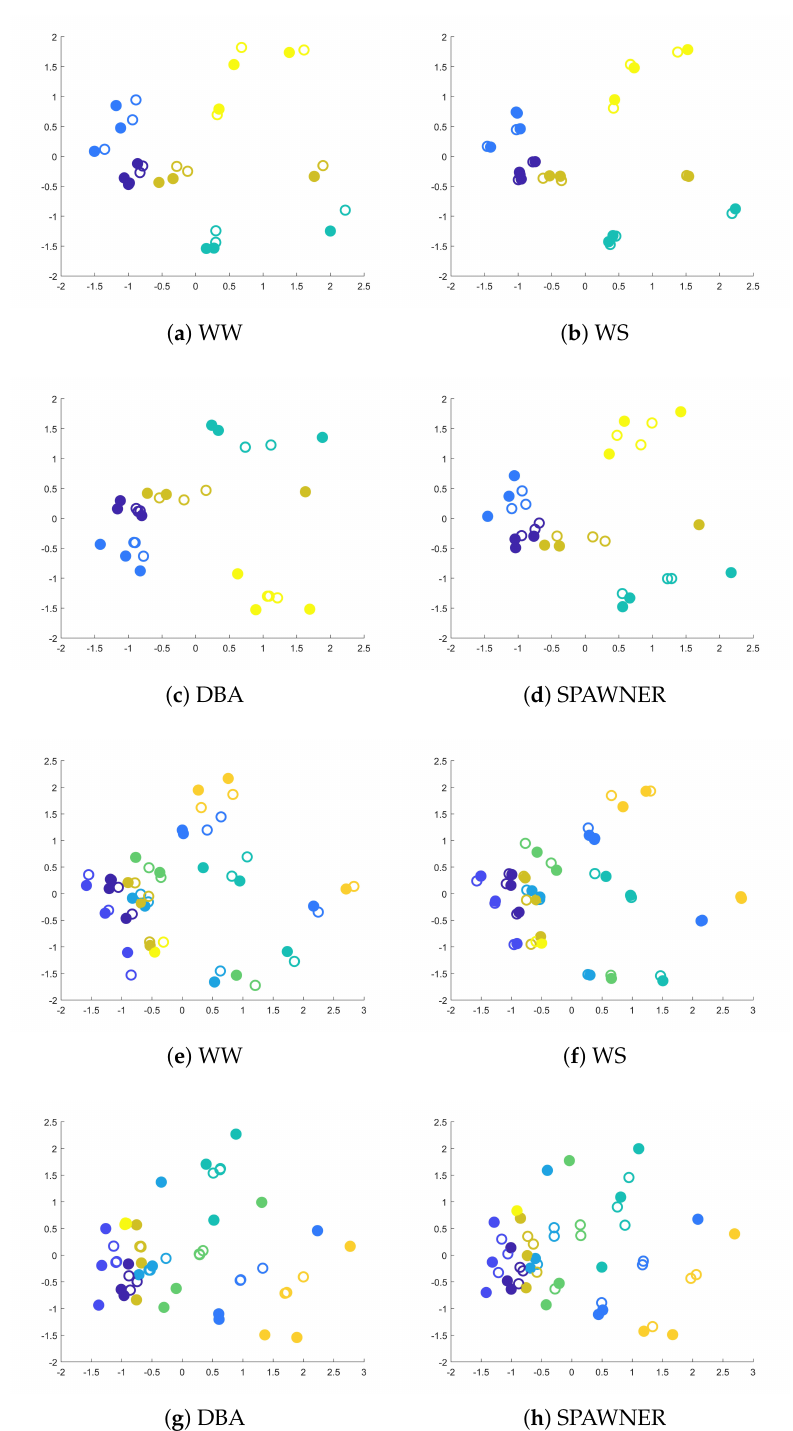
Figure 2. Scatter plots with two-dimensional MDS embedding of DTW dissimilarities between the first 15 (the first two rows) or 25 (the last two rows) training sequences from AUSLAN dataset, including augmented time-series generated by four methods. In the plots, the classes are denoted by colors, the filled circles denote input time-series, and the circles with white interior indicate synthetic